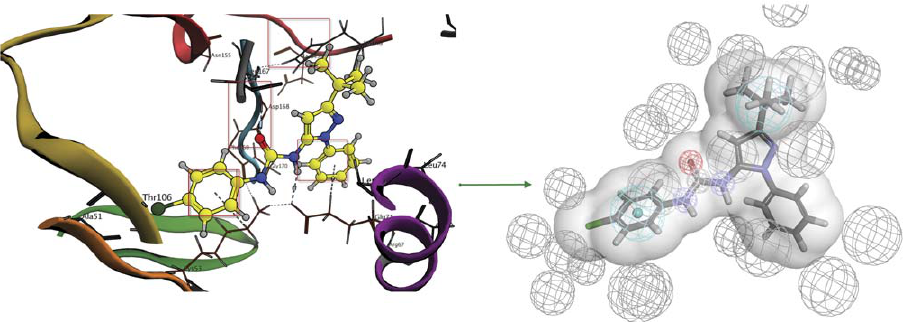
Figure 7. Structure-based pharmacophore construction general outline. The interactions are translated into pharmacophore features while the binding site amino acids are translated into excluded volumes. The shape of the binding site is also added to increase sensitivity of the pharmacophore.